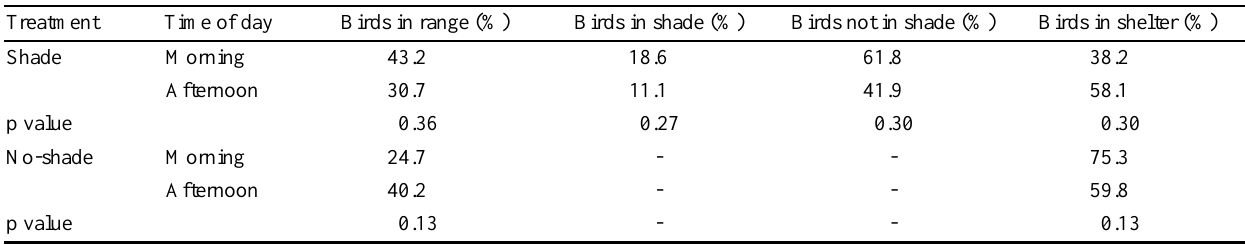
Table 1. The % of birds in the shelter, in the range, using the shade and not in the shade for the shade and no shade treatments